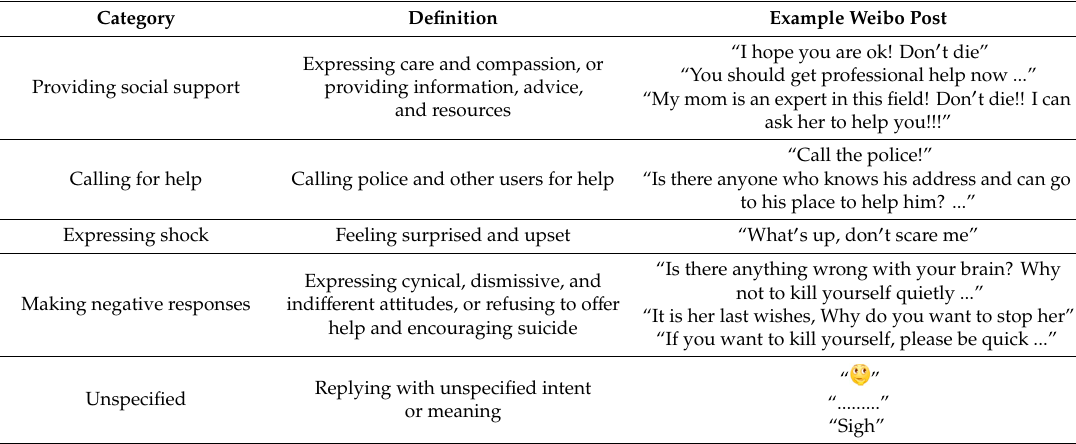
Table 2. Coding framework.